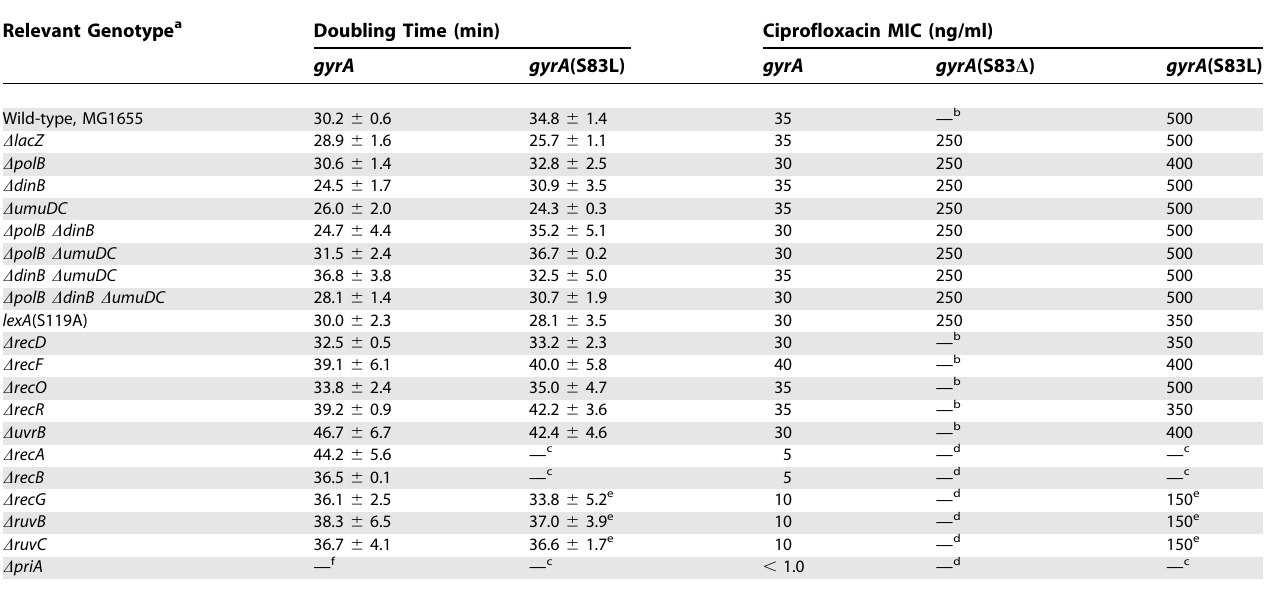
Table 2. Growth and Ciprofloxacin Sensitivity of MG1655-Derived Strains Relevant Genotype